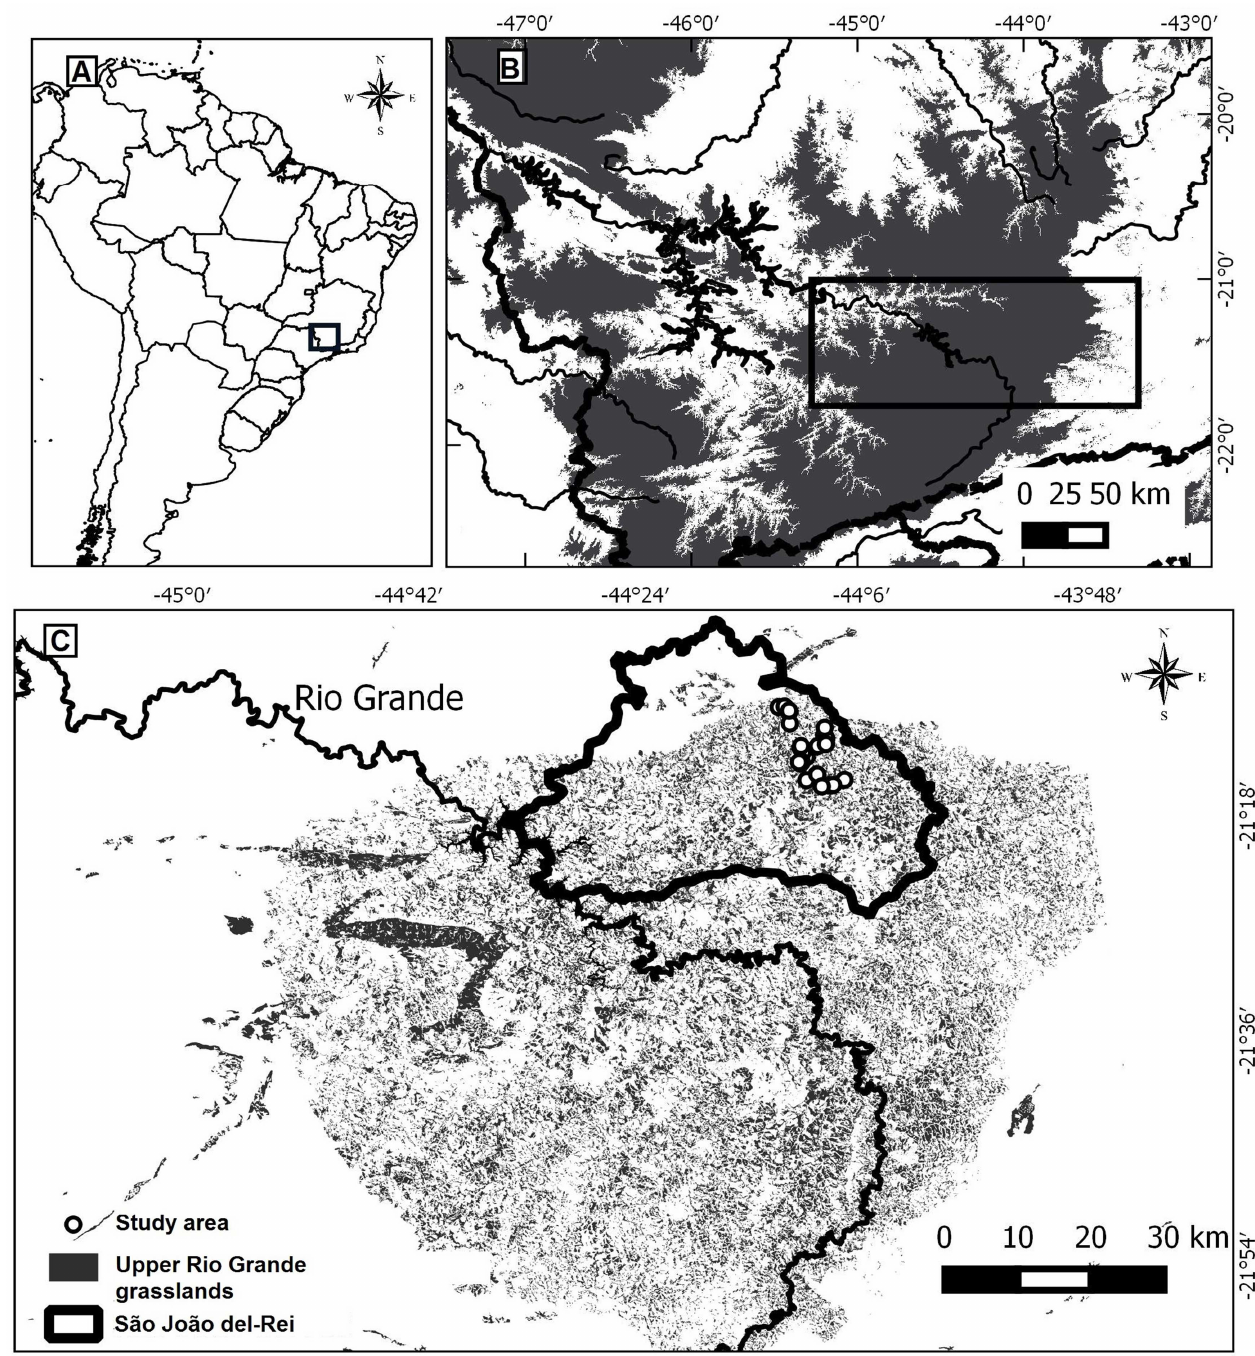
Fig 2. (A) Location of the study area. (B) Detail of the study area, depicting the Rio Grande. Grey areas are above 900 m a.s.l. (C) Detail of the study area, depicting the limits of the municipality of São João del-Rei and the remaining patches of natural grasslands.